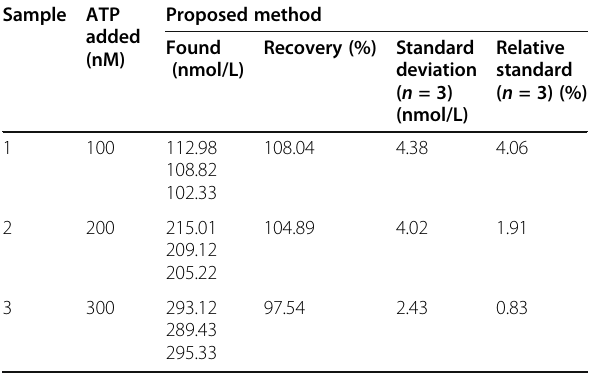
Table 5 ATP recovery test Sample ATP Proposed added (nM)